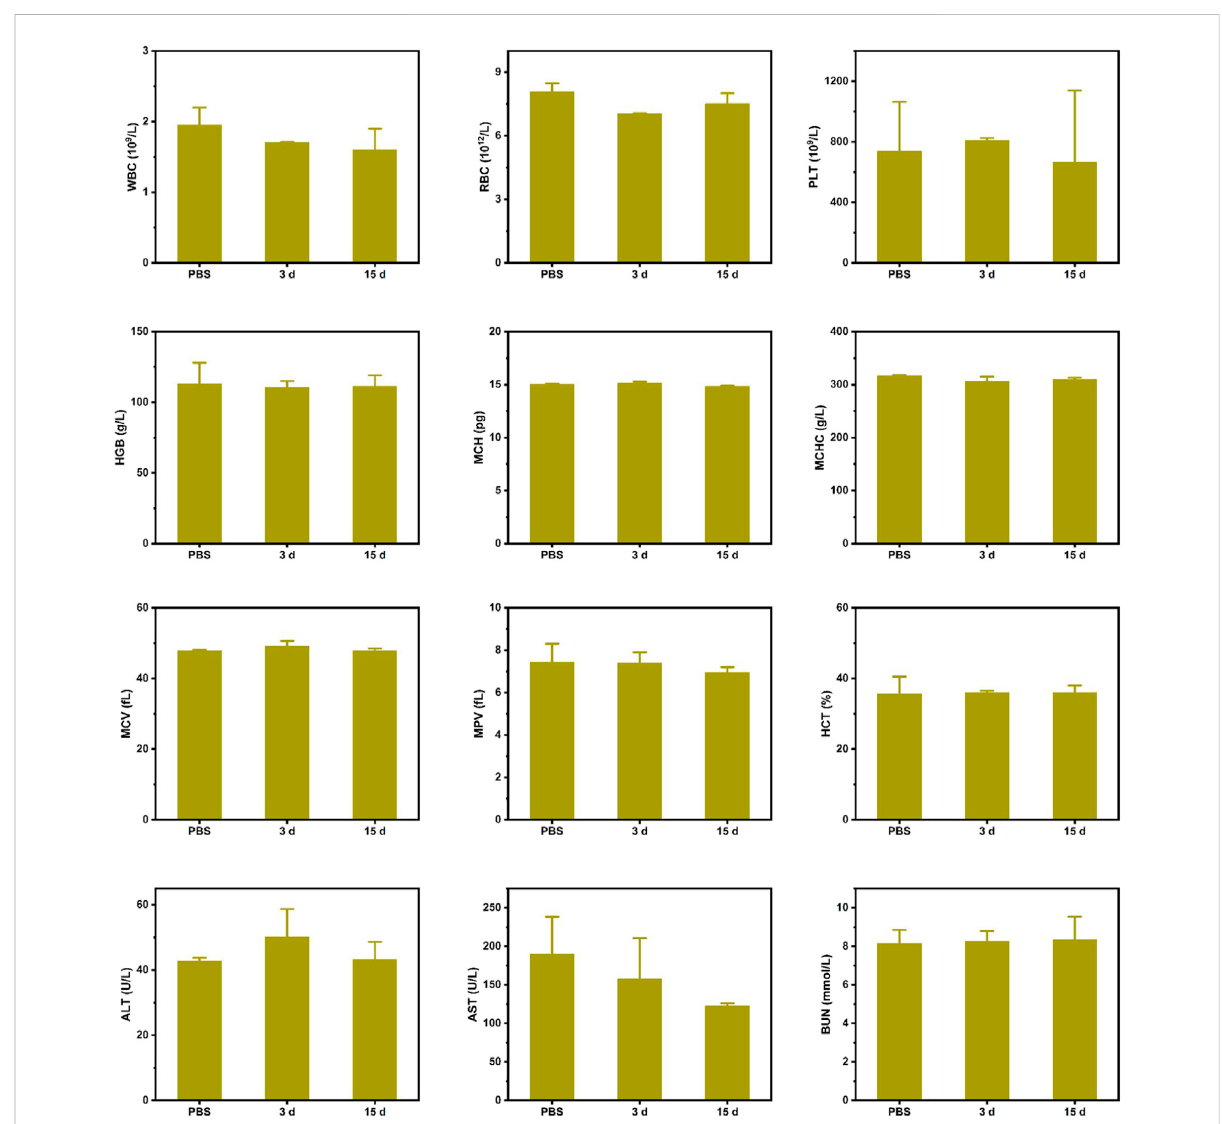
FIGURE 8 Major blood routine indexes, liver and kidney function indexes of mice after various